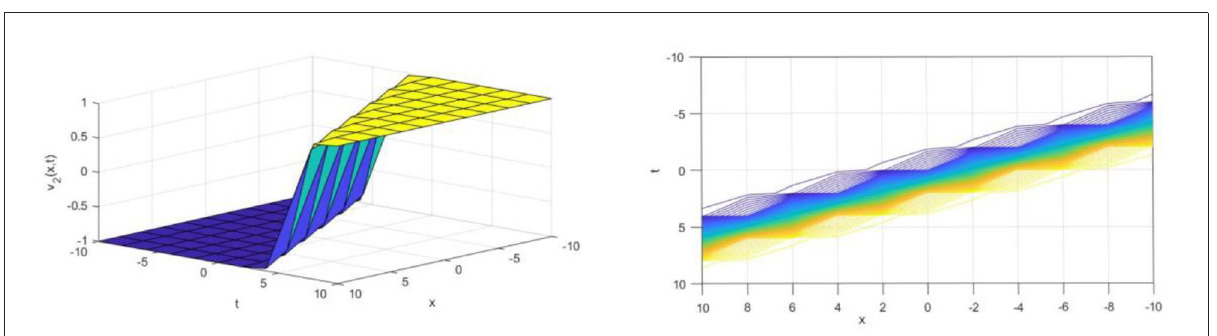
FIGURE6 The kink wave solution of v 2 ( x , t ) in 3D and